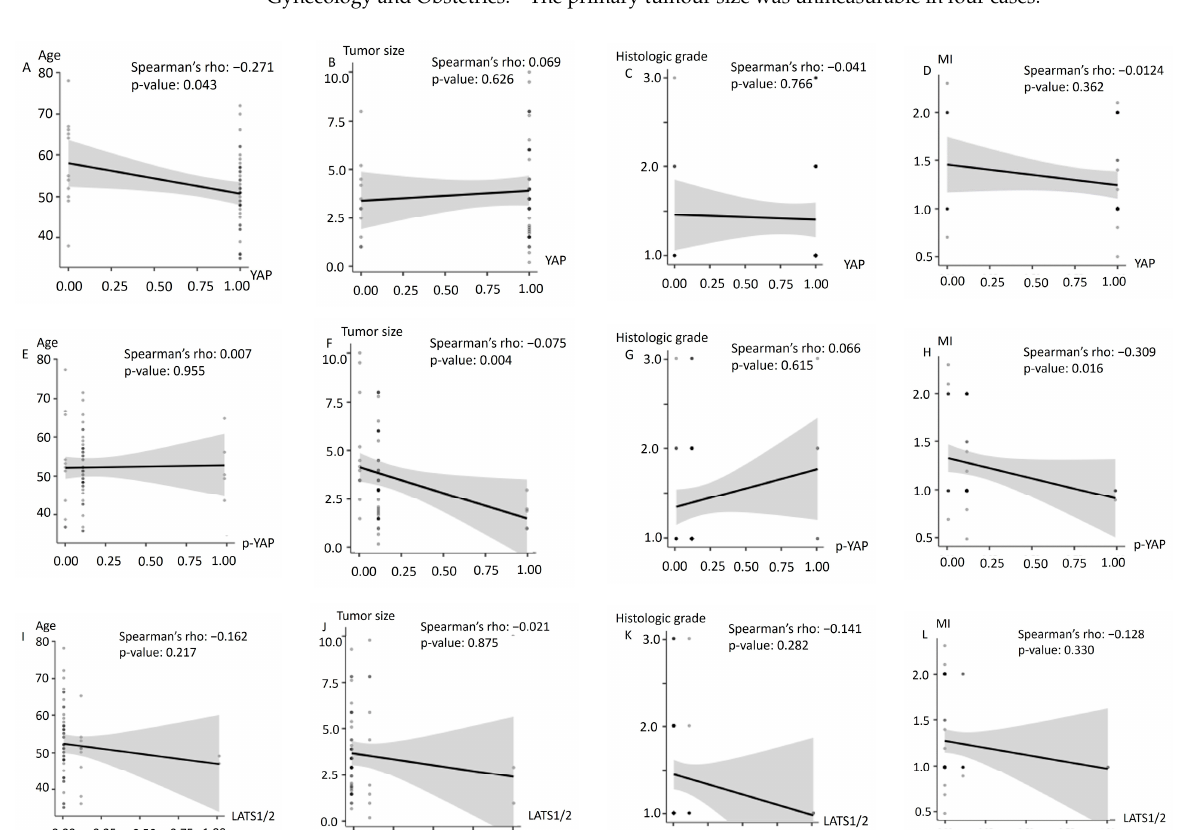
Table 3. Association between clinicopathological features and expression of YAP, p -YAP, and LATS1/2.